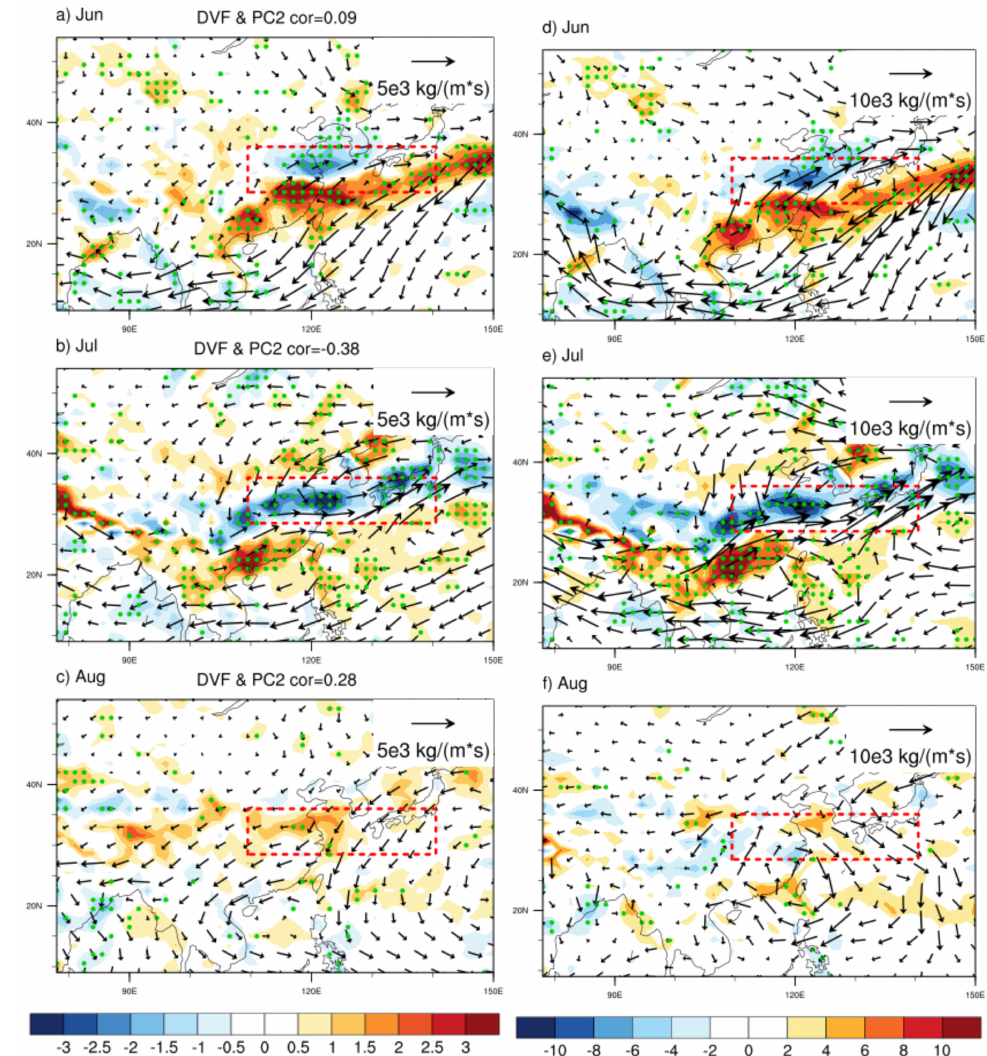
Figure 10. Same as Figure 7 but for PC2. Regression maps are ( a – c ) and difference maps are ( d – f